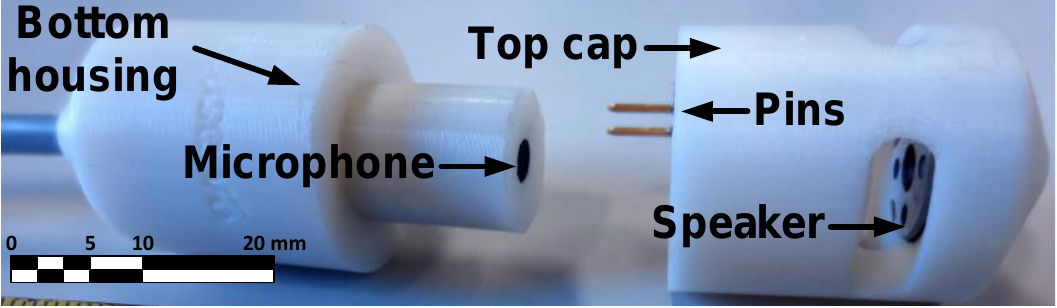
The self-testing noise measurement sensor is divided in two parts: a bottom housing that encloses the microphone capsule and its circuitry and a top cap with an embedded 13 mm speaker . The top cap fits on top of the bottom housing placing the speaker just 6 mm from the microphone capsule. The speaker audio signals are connected to the bottom housing and then to the main connector cable via the pair of metallic pins seen in the